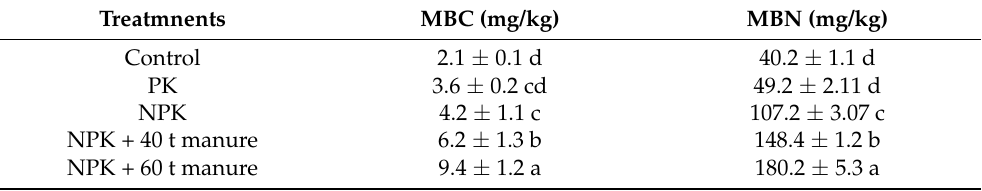
Mean ± SD. Lower case letters represent significant difference between treatments at p < 0.05.